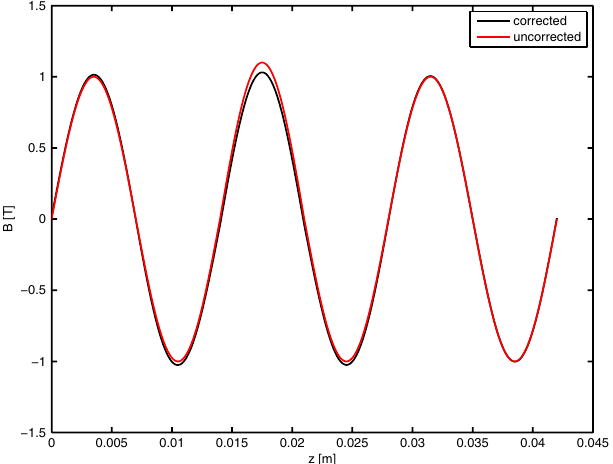
FIG. 8. (Color) Phase-error distribution for 1000 50-period un- dulators without induction shimming; (cid:7) (cid:2) B=B; coil ¼ (cid:7) (cid:2) B=B; pole ¼ 3 (cid:6) 10 (cid:3) 3